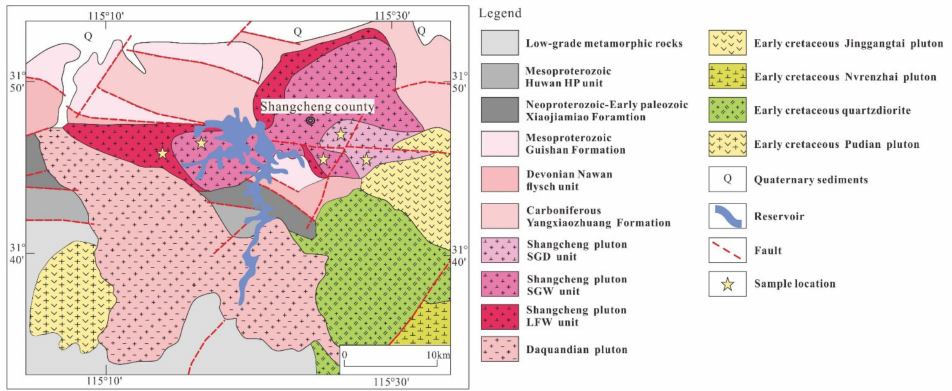
Figure 2. Simplified geological map of the Shangcheng pluton (modified after [38]). A porphyritic texture can be observed in SGD unit samples, and the phenocryst is dominated by potassium feldspar, which accounts for about 20% of the total content. The matrix is dominated by plagioclase (35%) and quartz (25%). Biotite (5–10%) and amphibole (5%) can be seen under single polarizer (3a), as can accessory minerals, such as apatite and magnetite (Figure 3a–c). A porphyritic-like structure can be observed in samples from the SGW unit, and potassium feldspar dominates the phenocrysts (20%). The matrix includes plagioclase (30%), quartz (30%), biotite (5%), and hornblende (Figure 3d–f). Some plagioclase has a ring structure (Figure 3e). Large potassic feldspar crystals (Figure 3h,i) can be seen locally in samples from the LFW unit. Quartz, plagioclase, and biotite are encapsu- lated in the potassic feldspar phenocrysts (Figure 3g,h). The matrix is dominated by quartz